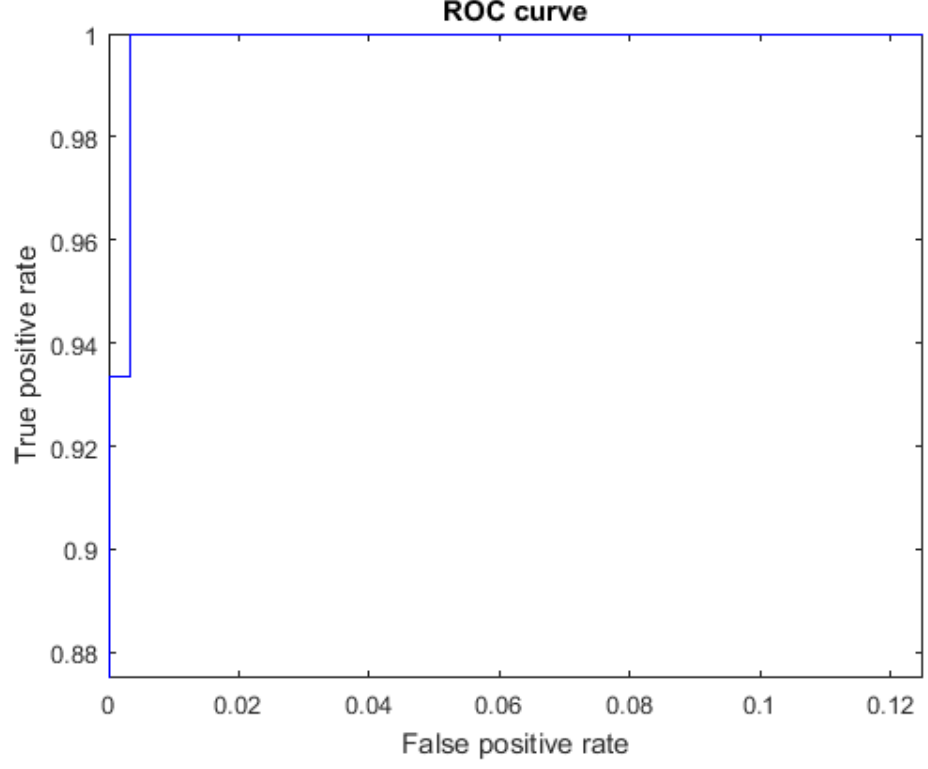
Figure 7. ROC curve for the letter E using spherical features, AUC = 0.9998.